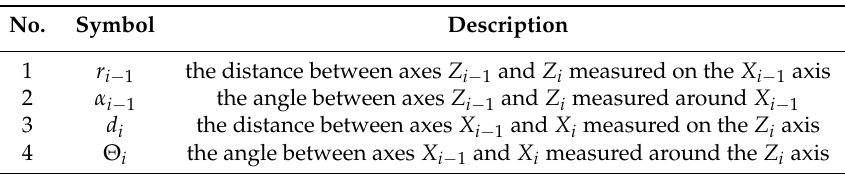
Table 1. Denavit–Hartenberg